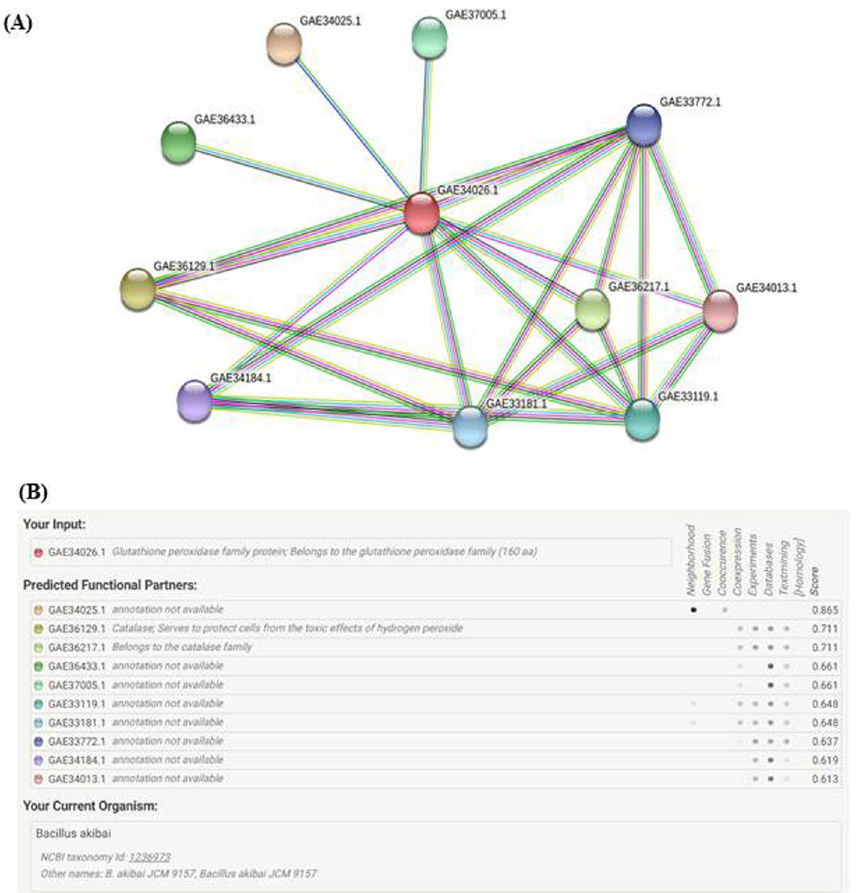
Fig. 9 ( A ) The protein-protein interaction network of different antioxidant enzymes with Glutathione peroxidase (GAE34026.1) in Bacillus akibai . The network was created using the STRING algorithm, and strong interactions are represented by thicker lines. ( B ) Data shows the interaction score of Glutathione peroxidase (GAE34026.1) with other functional partners. The highest score in Neighbourhood and gene fusion is 0.865 but the annotation was unavailable. Second highest interaction score was 0.711 for two enzymes- Catalase (GAE36129.1) and another enzyme belongs to the catalase family (GAE36217.1) , both of them protects the cells from the harmful effects of hydrogen peroxide. Alteration of intracellular enzyme expressions is a key mechanism of the deterioration of Glutathione peroxidase enzyme pathway caused by